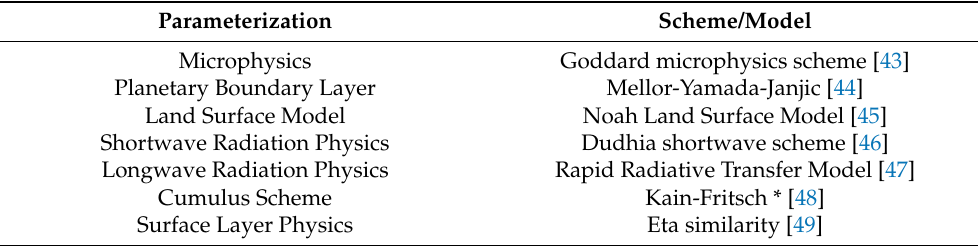
Table 5. WRF-ARW parameterizations used for this study (same as